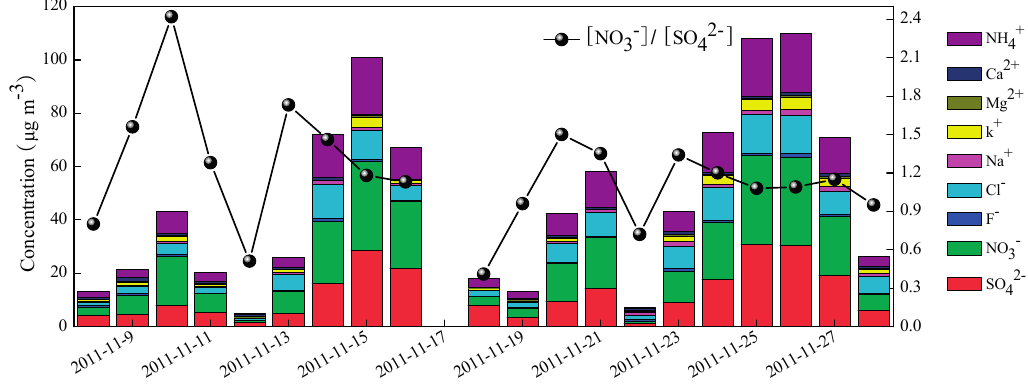
Figure 2. Daily variations of water-soluble ions and [NO 3 − ]/[SO 42 − ]